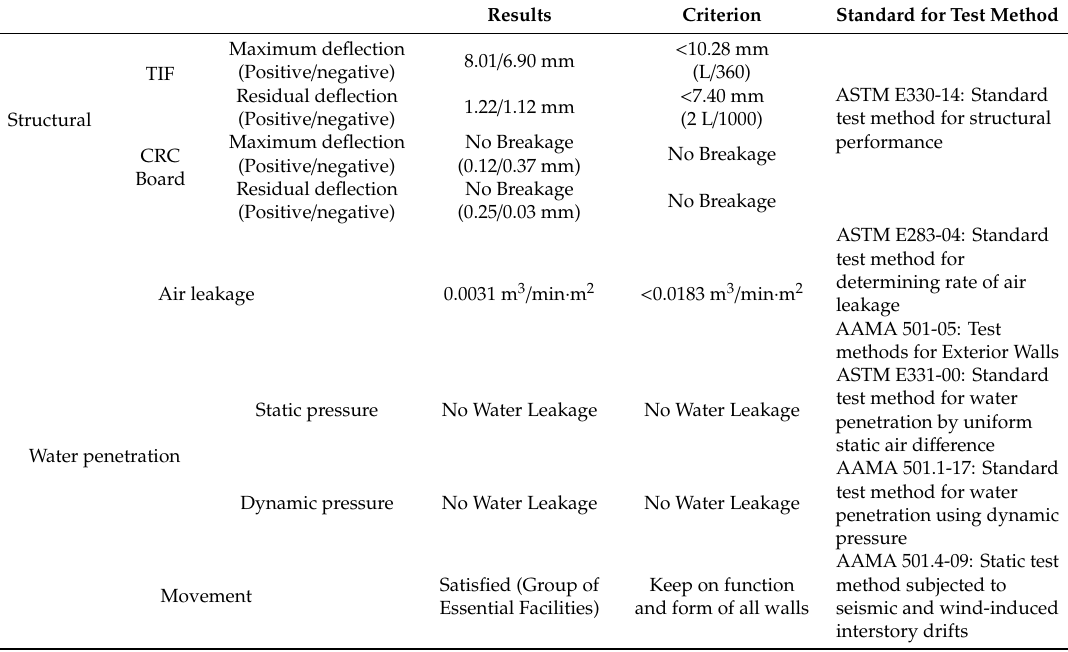
Table 1. Results of the curtain wall mock-up